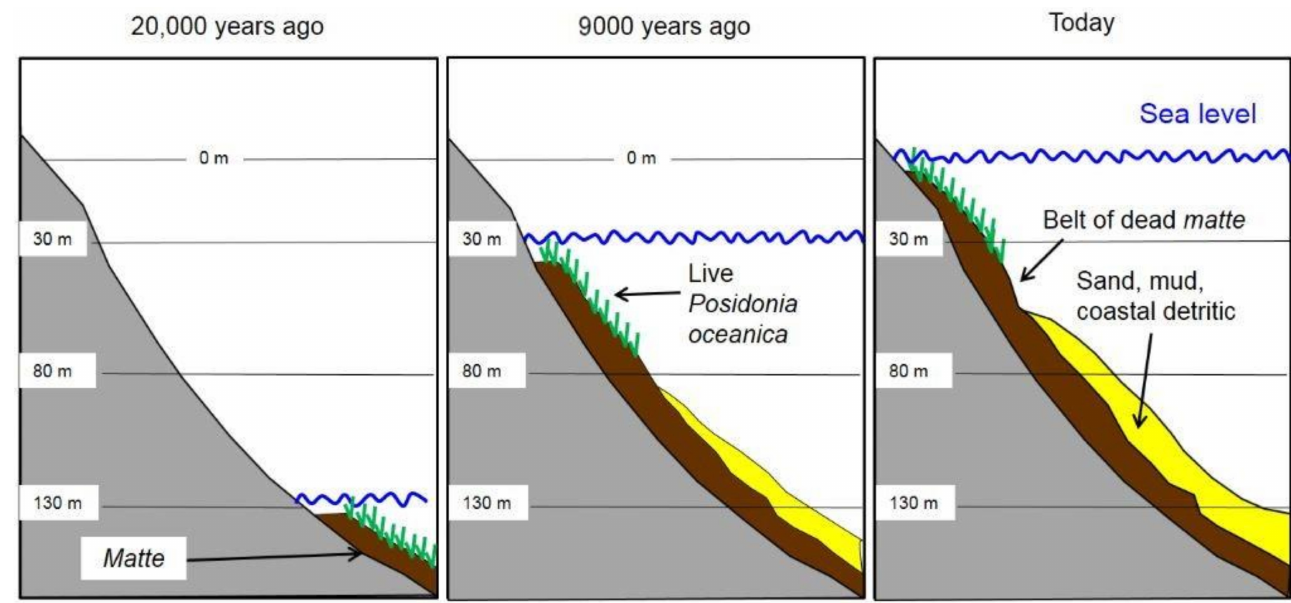
Figure 6. The post-LGM (Last Glacial Maximum) rise in sea level. Posidonia oceanica meadows have spread upwards, following the rise in sea level, leaving behind a belt of dead matte of natural origin. This belt could be confused with modern